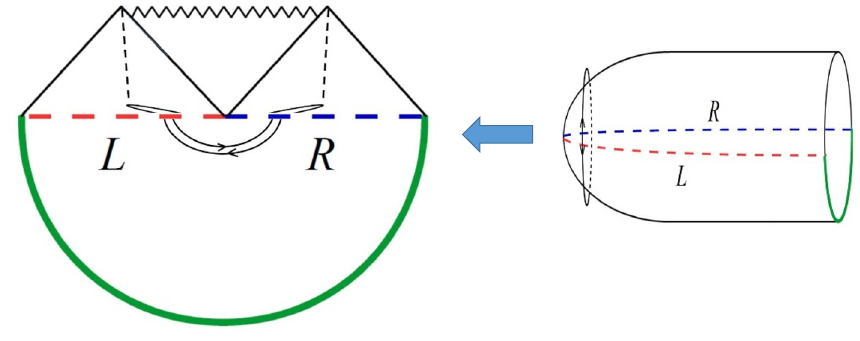
Figure 1 . The target-space interpretation of the CFT fusion (1.1): in the Euclidean section (on the right), the cigar background is accompanied, due to the FZZ duality, with a condensate of winding ! = (cid:6) 1 strings, denoted in the text by W (cid:6) . As usual, the Lorentzian section is obtained by cutting the cigar and analytically continue. When doing so, W (cid:6) are combined to form a folded string, that folds towards the